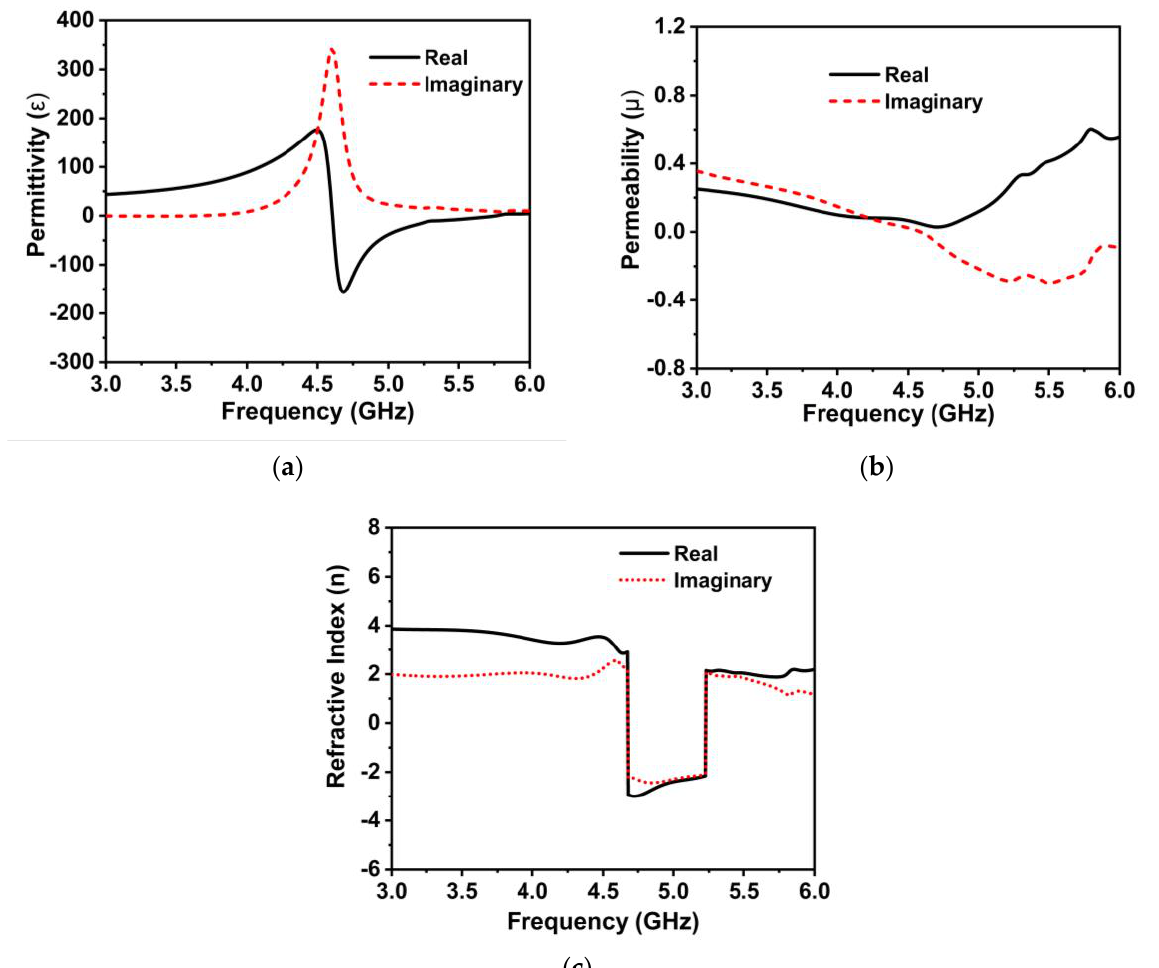
Figure 2. Effective extracted parameters ( a ) permittivity plot, ( b ) permeability plot, and ( c ) refractive index plot.